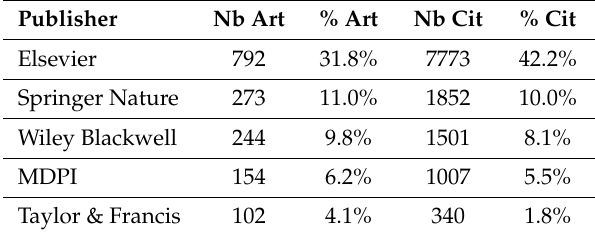
Table 4. Most important publishers with number and share of articles and citations ( n =